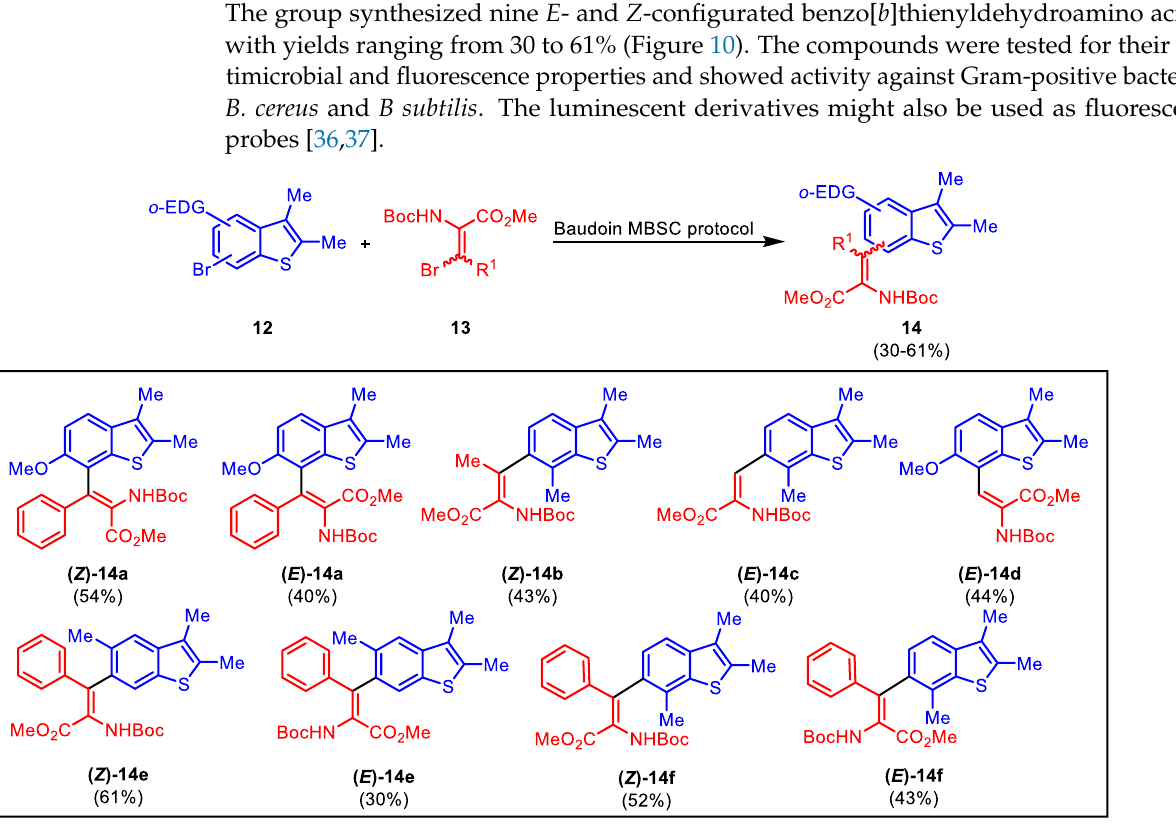
Figure 10. Queiroz’ one -pot MBSC synthesis of benzo[ b ]thienyldehydroamino acid esters 14 [37,38].